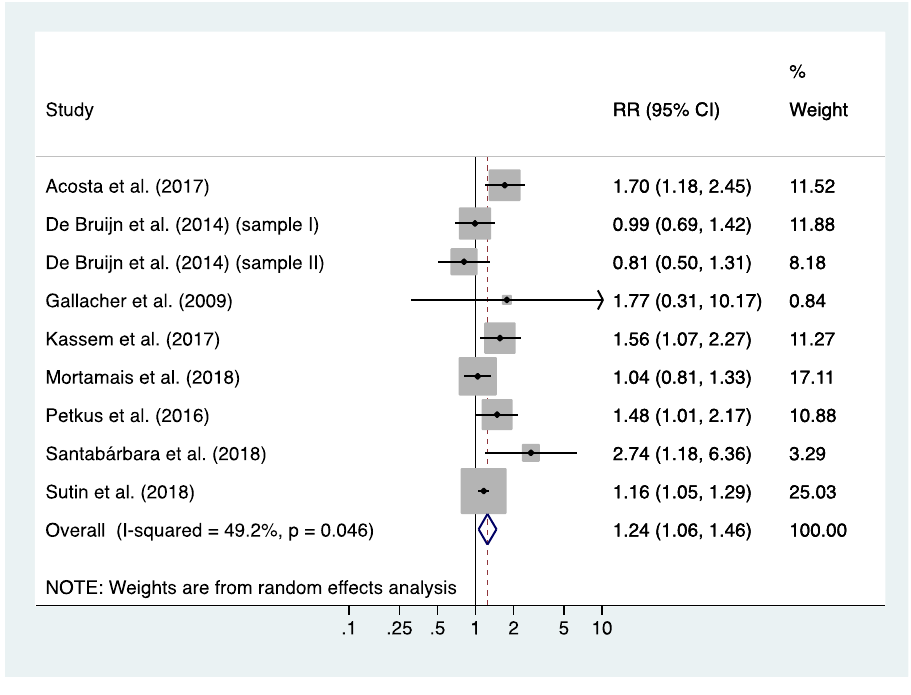
Table 2. Univariate meta-regression results for the log(RR).